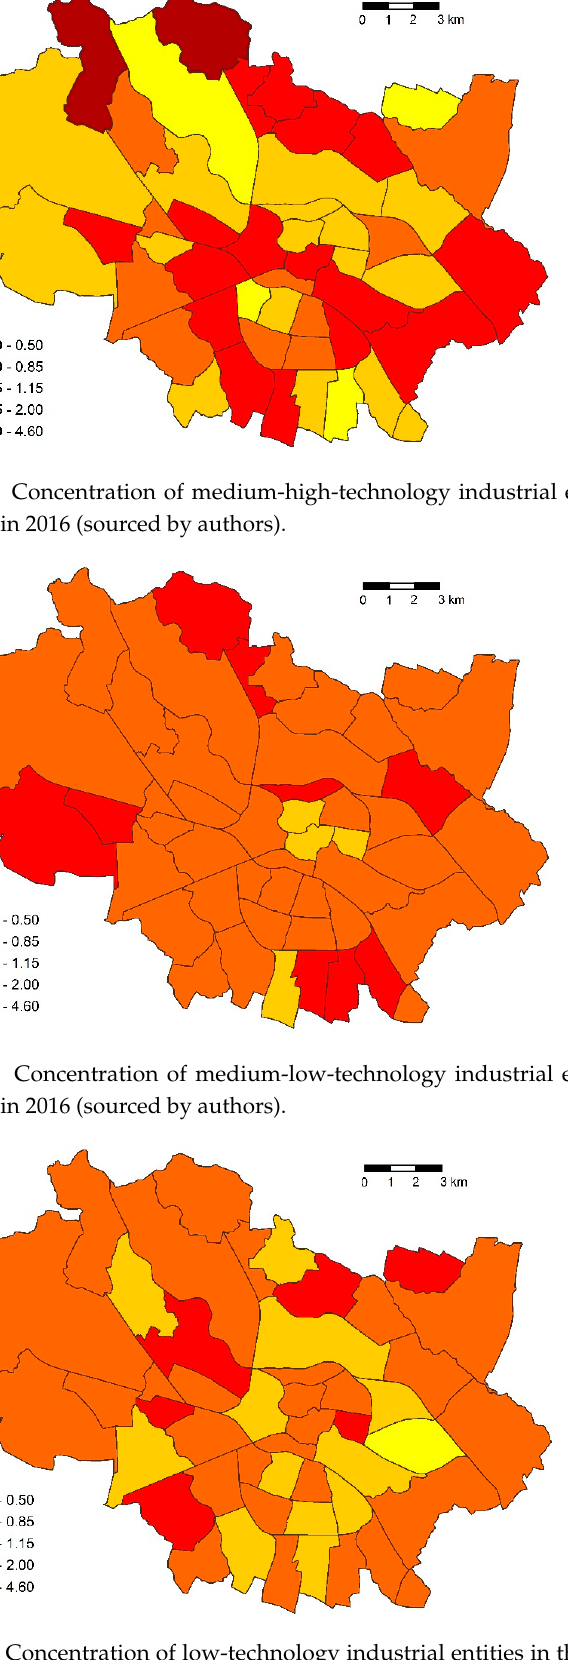
Figure 9. Concentration of low-technology industrial entities in the housing estate of Wroc ł aw in 2016 (sourced by authors). 2016 (sourced by